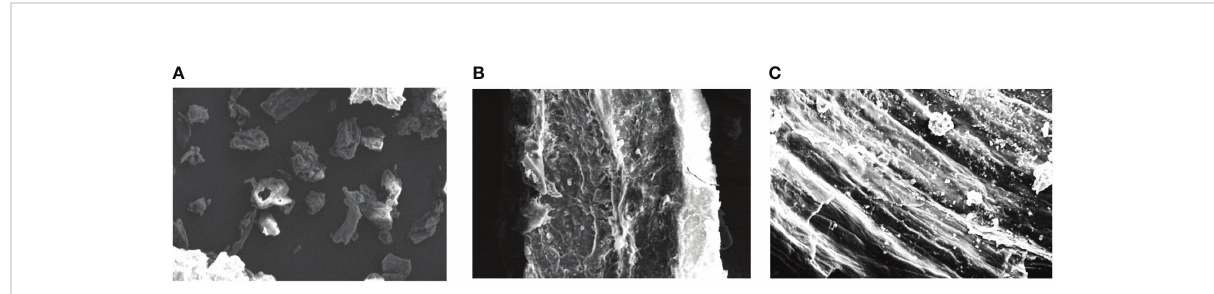
FIGURE 7 SEM of different samples (A) Unprocessed sample (B) after maceration (C)